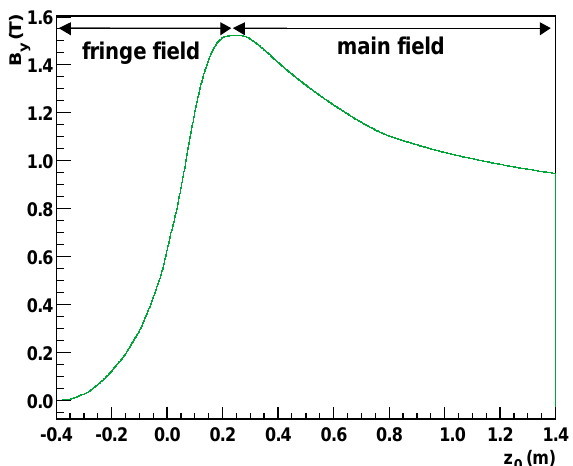
FIG. 3. (Color) Magnetic field B y (cid:1) z 0 (cid:2) in the midplane of a 90 ± HDSM bending